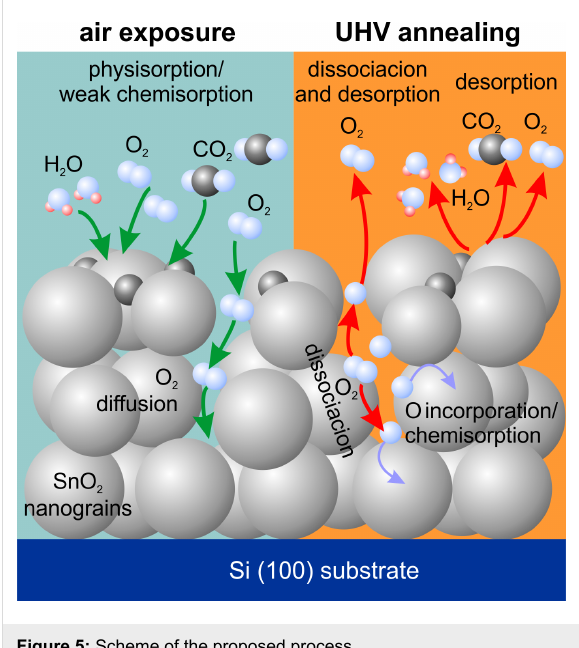
Figure 5: Scheme of the proposed